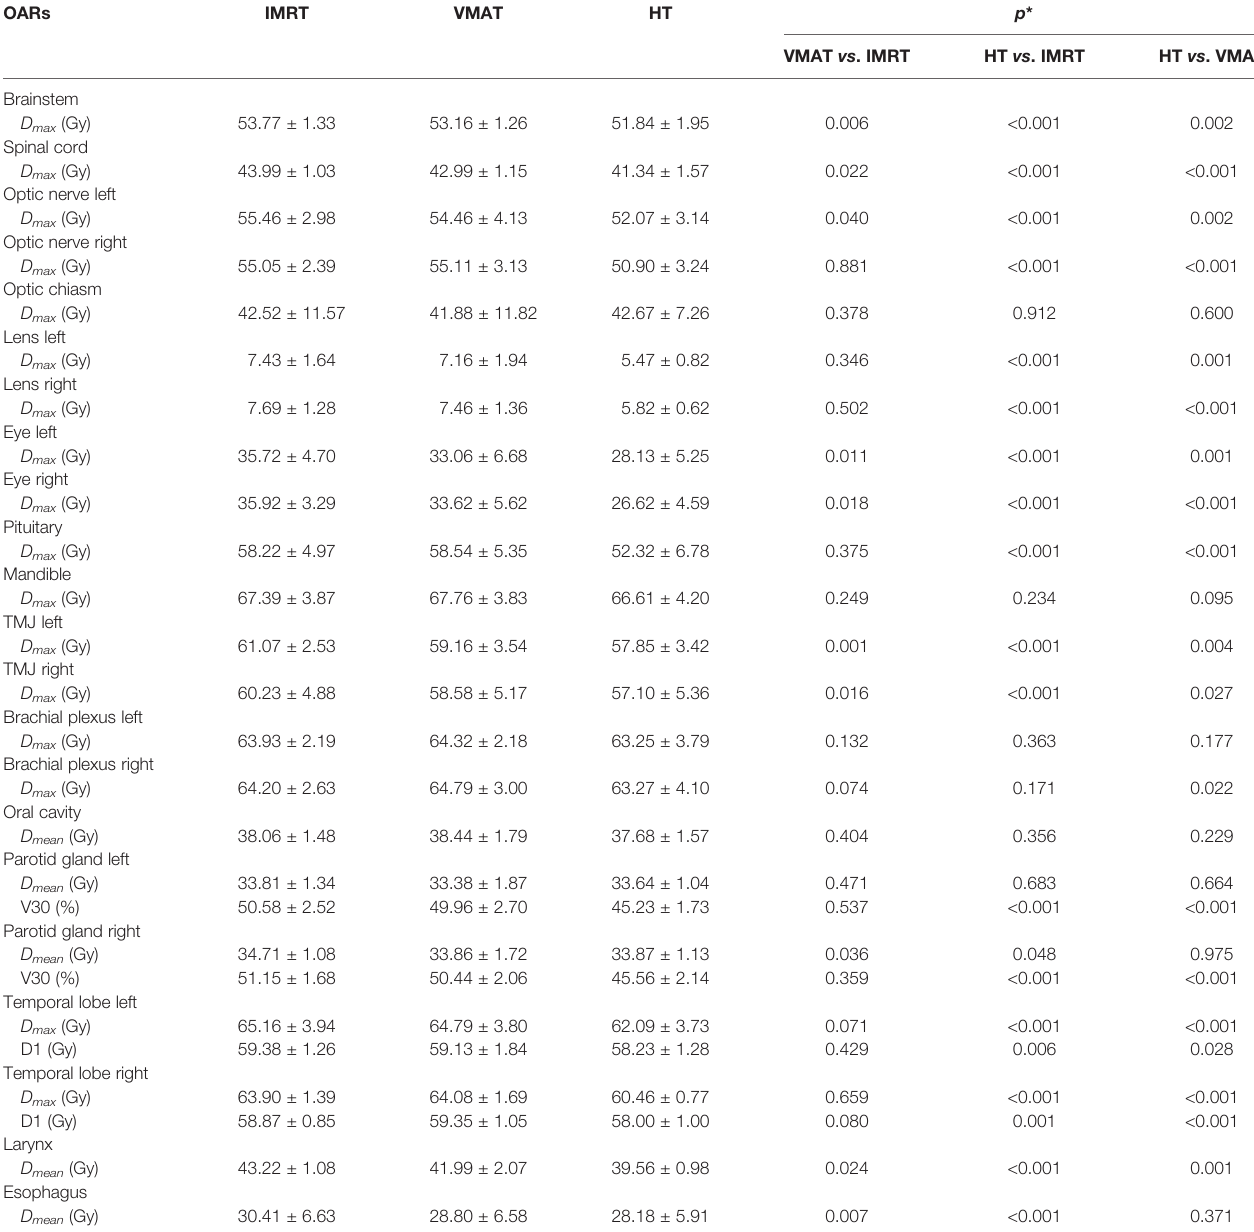
TABLE 4 | Dose – volume histogram comparisons for the main OARs of three plans. OARs IMRT VMAT